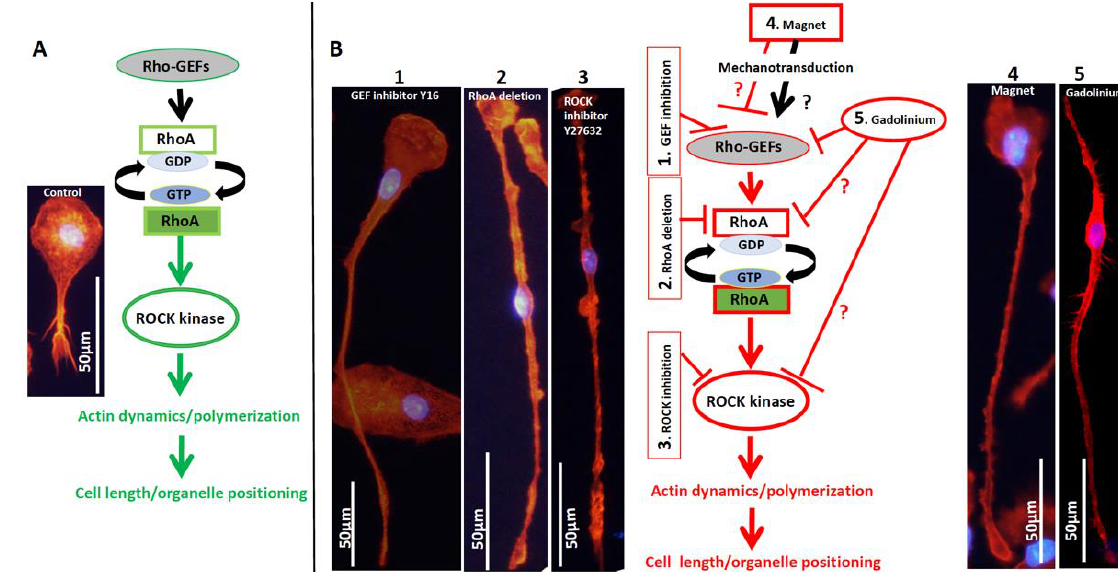
Figure 12. Hypothetical effects of RhoA pathway interference (using inhibitors, RhoA KO, gadolinium, and the magnetic field gradient) on the actin cytoskeleton and cell length. ( A ) The length of a typical MO (unstimulated) macrophage was usually below 100 µ M. The cell morphology and distribution of the organelles were actin-dependent and regulated by the RhoA pathway. RhoA